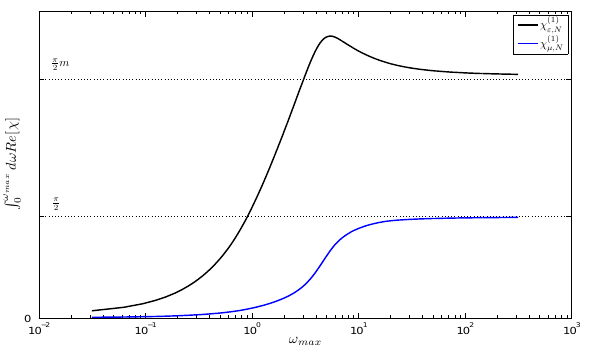
Fig. 5. Comparison between the linear susceptibility of the intensive Figure 5: Comparison between the linear susceptibility of the intensive energy for the global energy for the global perturbation and of the total energy for the perturbation and of the total energy for the local perturbation. The signals are the same local perturbation. The signals are the same except for the different except for the different level of noise. level of noise.